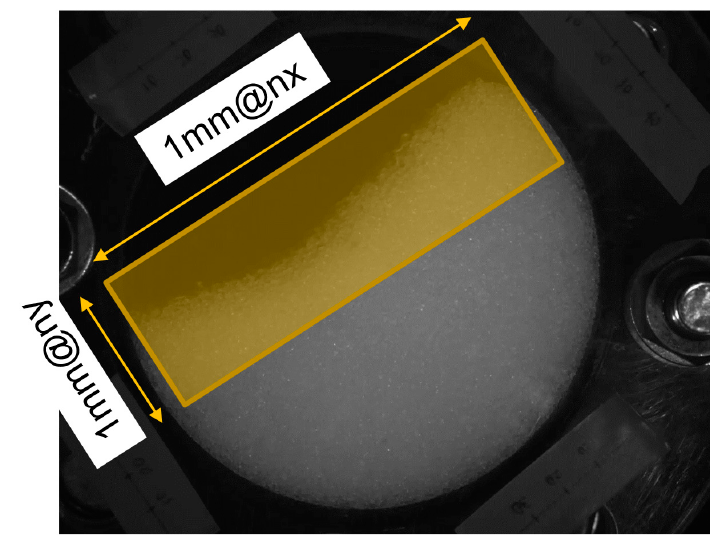
Figure 6. Target area for simulation. Geosciences 2019 , 9 , x FOR PEER REVIEW